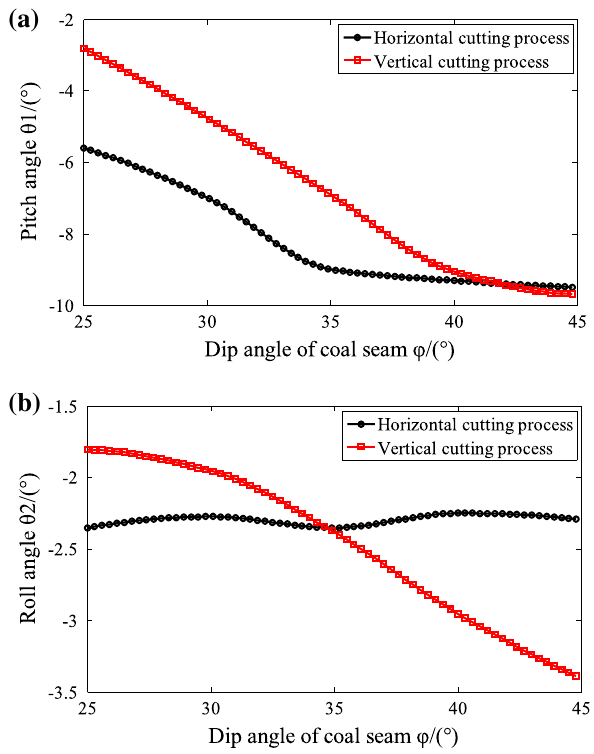
Fig. 9 Relationship between the attitude angles and dip angle of coal seam. ( a ) Pitch angle and dip angle of coal seam; ( b ) Roll angle and dip angle of coal